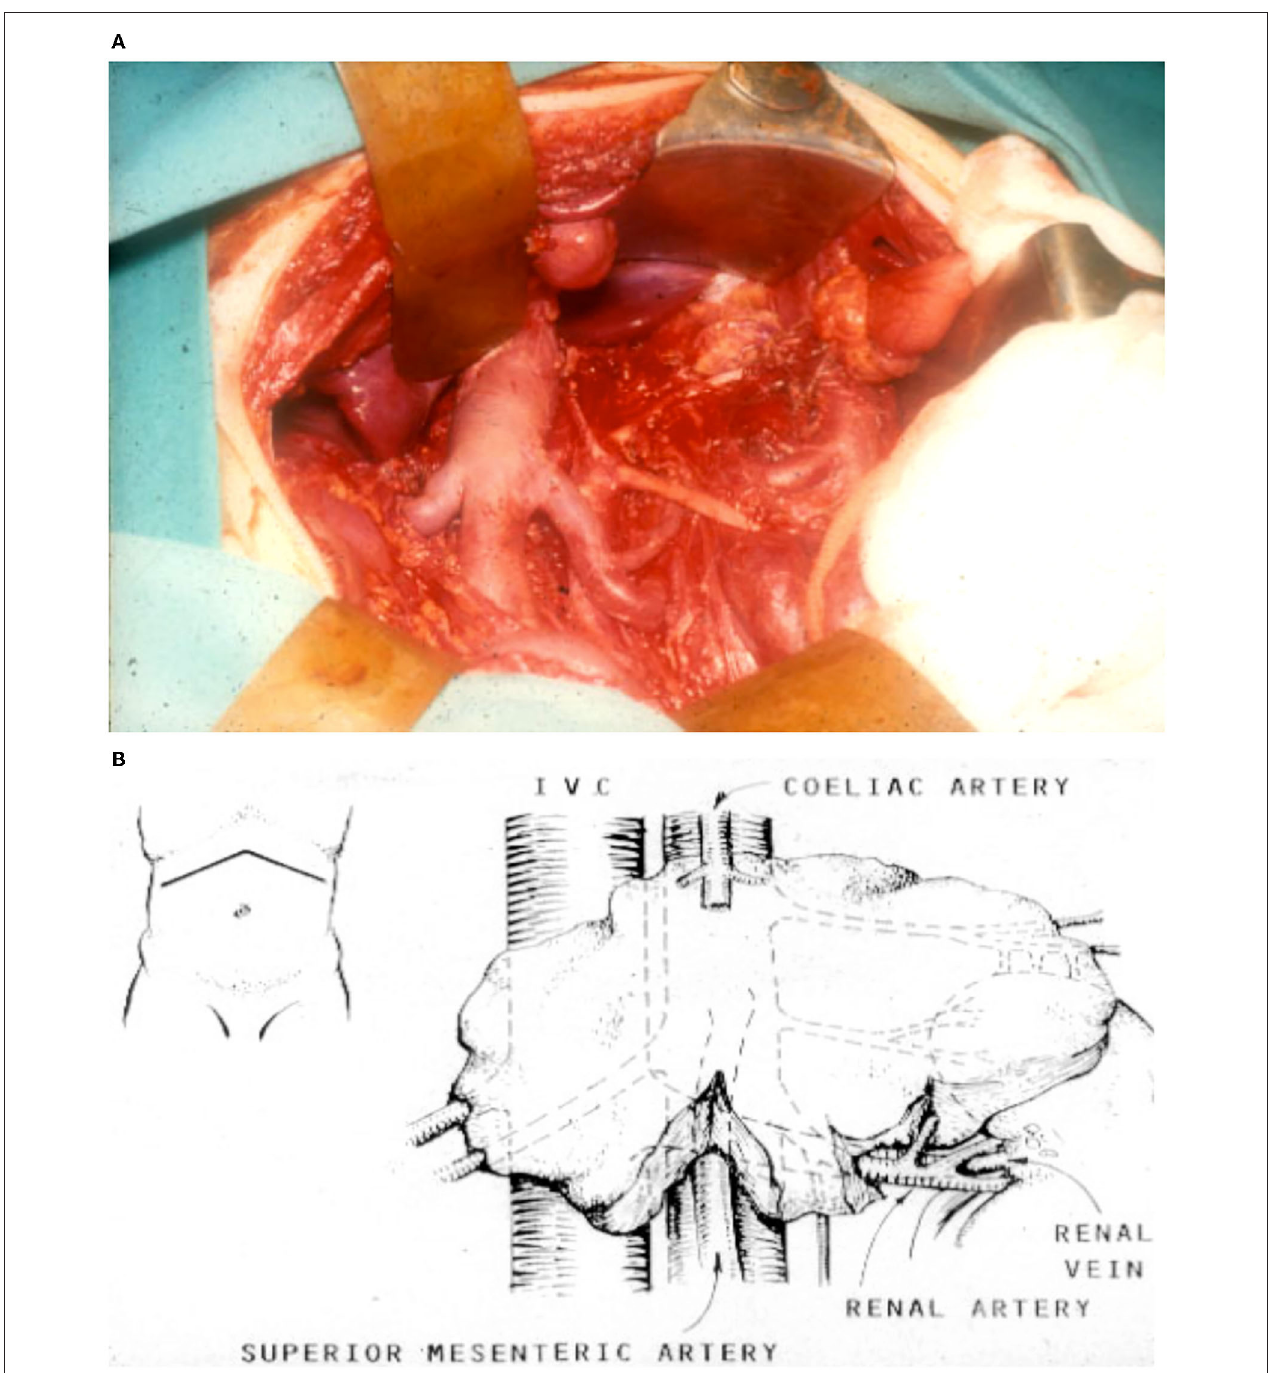
FIGURE 7 | (A) Operative field photograph following gross total resection of an abdominal neuroblastoma tumor. (B) Schematic image of neuroblastoma tumor. Note a precise and painstaking careful skeletonization of major vasculature is required for a successful operation.